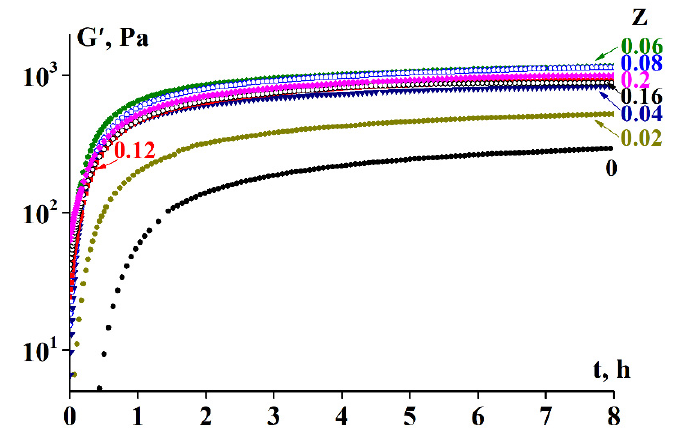
Figure 5. Gelation kinetics of SA-gelatin complexes at the Z values shown on the curves, T = 4 °C. (The initial temperature of the samples was 25 ° C), ω = 6.28 rad/s, γ = 1%.